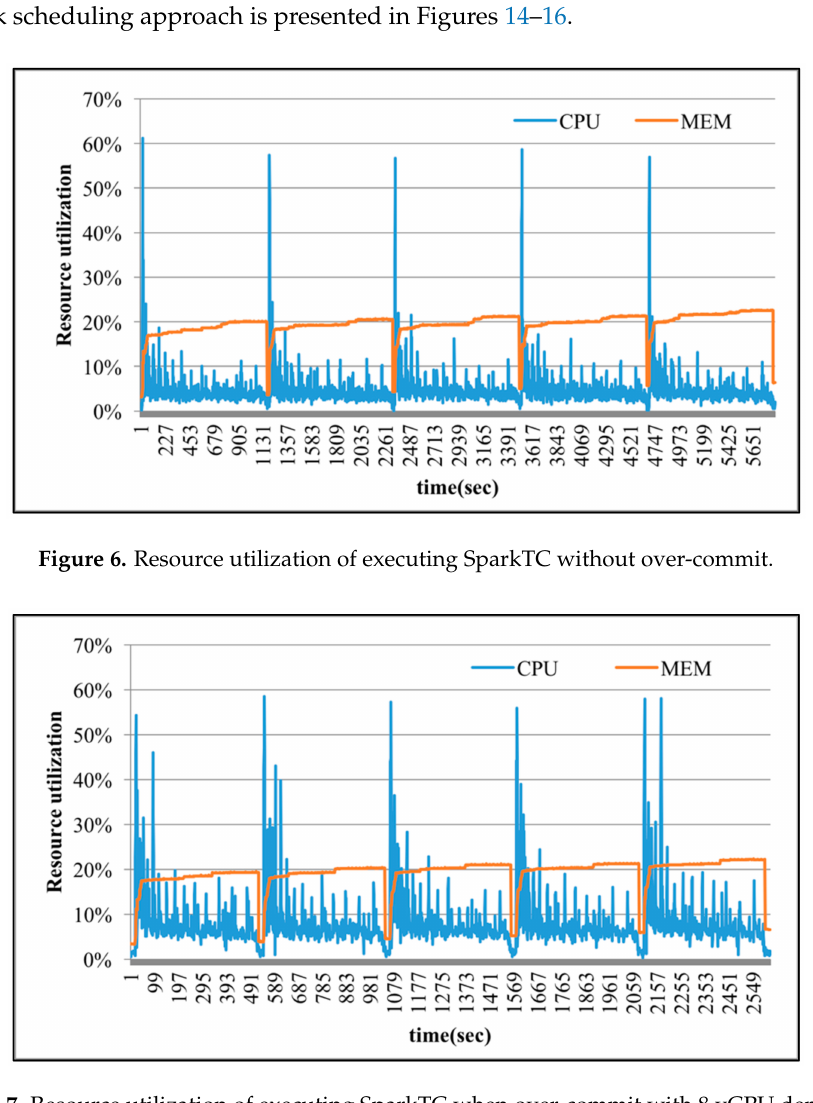
Figure 7. Resource utilization of executing SparkTC when over-commit with 8 vCPU